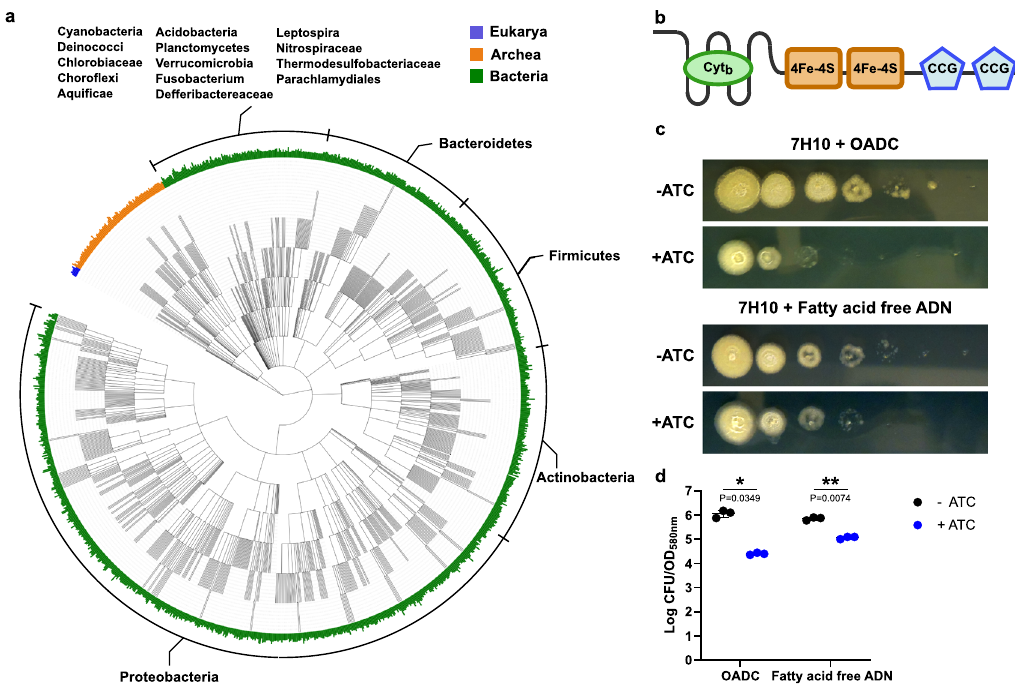
Fig. 1 EtfD is a membrane protein possibly involved in Mtb ’ s energy metabolism. a Rootless phylogenetic tree with species containing members of COG0247 according to the database of the webtool EggNog. The inner colored ring corresponds to life domains, while the outer ring refers to bacteria phyla. b Domain architecture of EtfD based on the algorithms of HHPred and Xtalpred. Cyt b cytochrome b, CCG cysteine-rich domain. c Spot assay on solid media with an EtfD-TetOFF strain, where protein levels are controlled by anhydrotetracycline (ATC). Serial dilutions (10 6 down to 1 bacteria) were incubated for 14 days. These results are representative of three independent experiments. d Quanti fi cation of spot assays ( c ). This quanti fi cation aggregates the data from the three independent experiments. To quantify the spot assays, we picked the fi rst dilution where isolated CFUs could be counted and divided it by the optical density (OD) of the corresponding bacterial suspension. The discrepancy between the OD of the bacterial suspension and the corresponding CFUs, which is due to sensitivity to lipids in the solid media, is re fl ected by this ratio. Data are averages with individual data points depicted. Error bars correspond to standard deviation. Statistical signi fi cance was assessed through paired two-tailed t -test. * P < 0.05; ** P < 0.01.